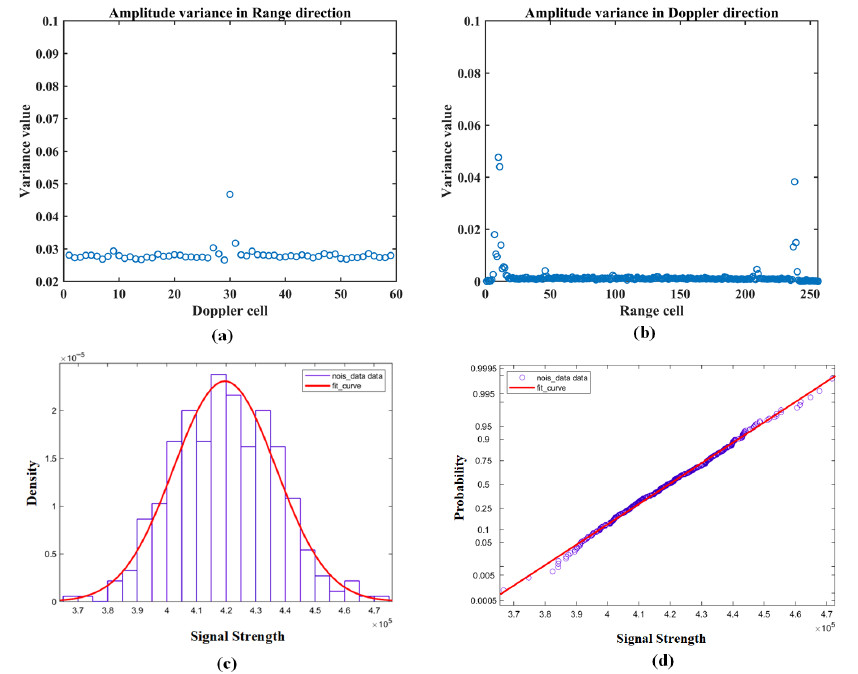
Figure 7. Background noise amplitude dispersion analysis in non-zero-Doppler region. ( a ) Noise amplitude variance in range direction. ( b ) Noise amplitude variance in Doppler direction. ( c ) Noise distribution curve. ( d ) Matching degree of Normal distribution.